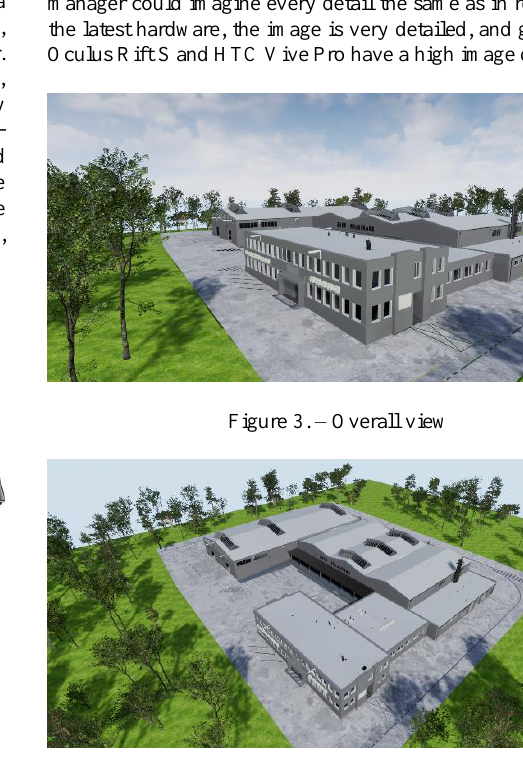
Figure 4. – View on whole